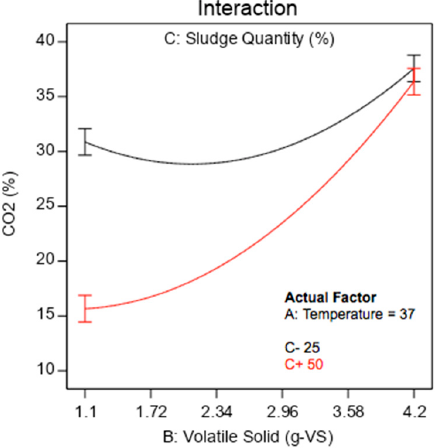
Figure 13. Interaction plot clarifying the effect of interaction between volatile solid and sludge quantity on CO 2 %.